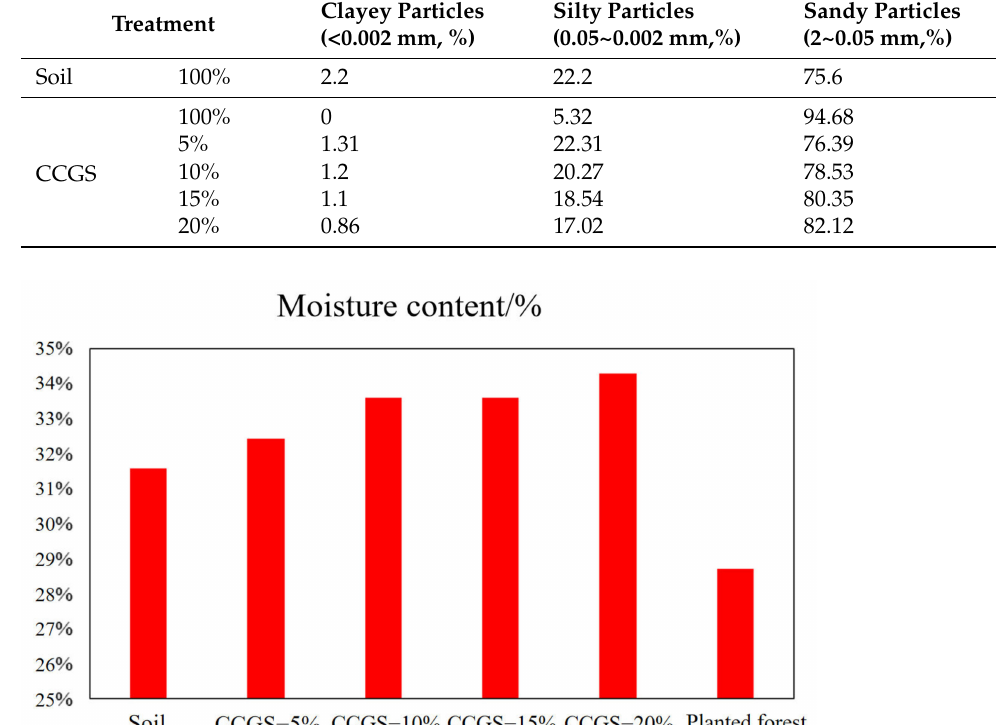
Figure 11. Effect of CCGS on soil water retention